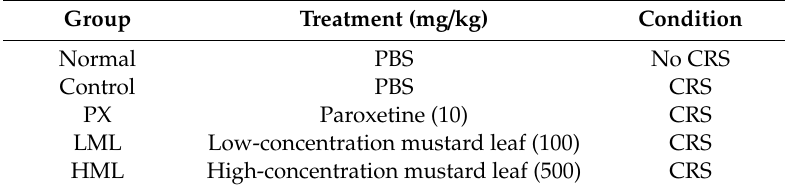
Table 1. Animal experimental groups and treatments. Group Treatment (mg / kg) Condition